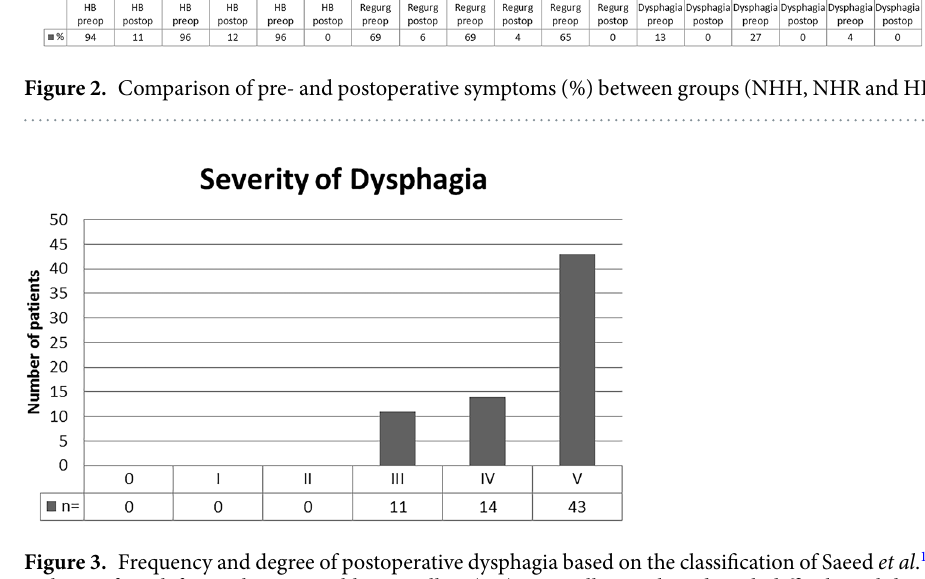
Figure 3. Frequency and degree of postoperative dysphagia based on the classification of Saeed et al . 14 . Columns from left to right: 0 = Unable to swallow (0%) I = Swallowing liquids with difficulty, solids impossible (0%) II = Swallowing liquids without difficulty, solids impossible (0%) III = Occasionally difficulty